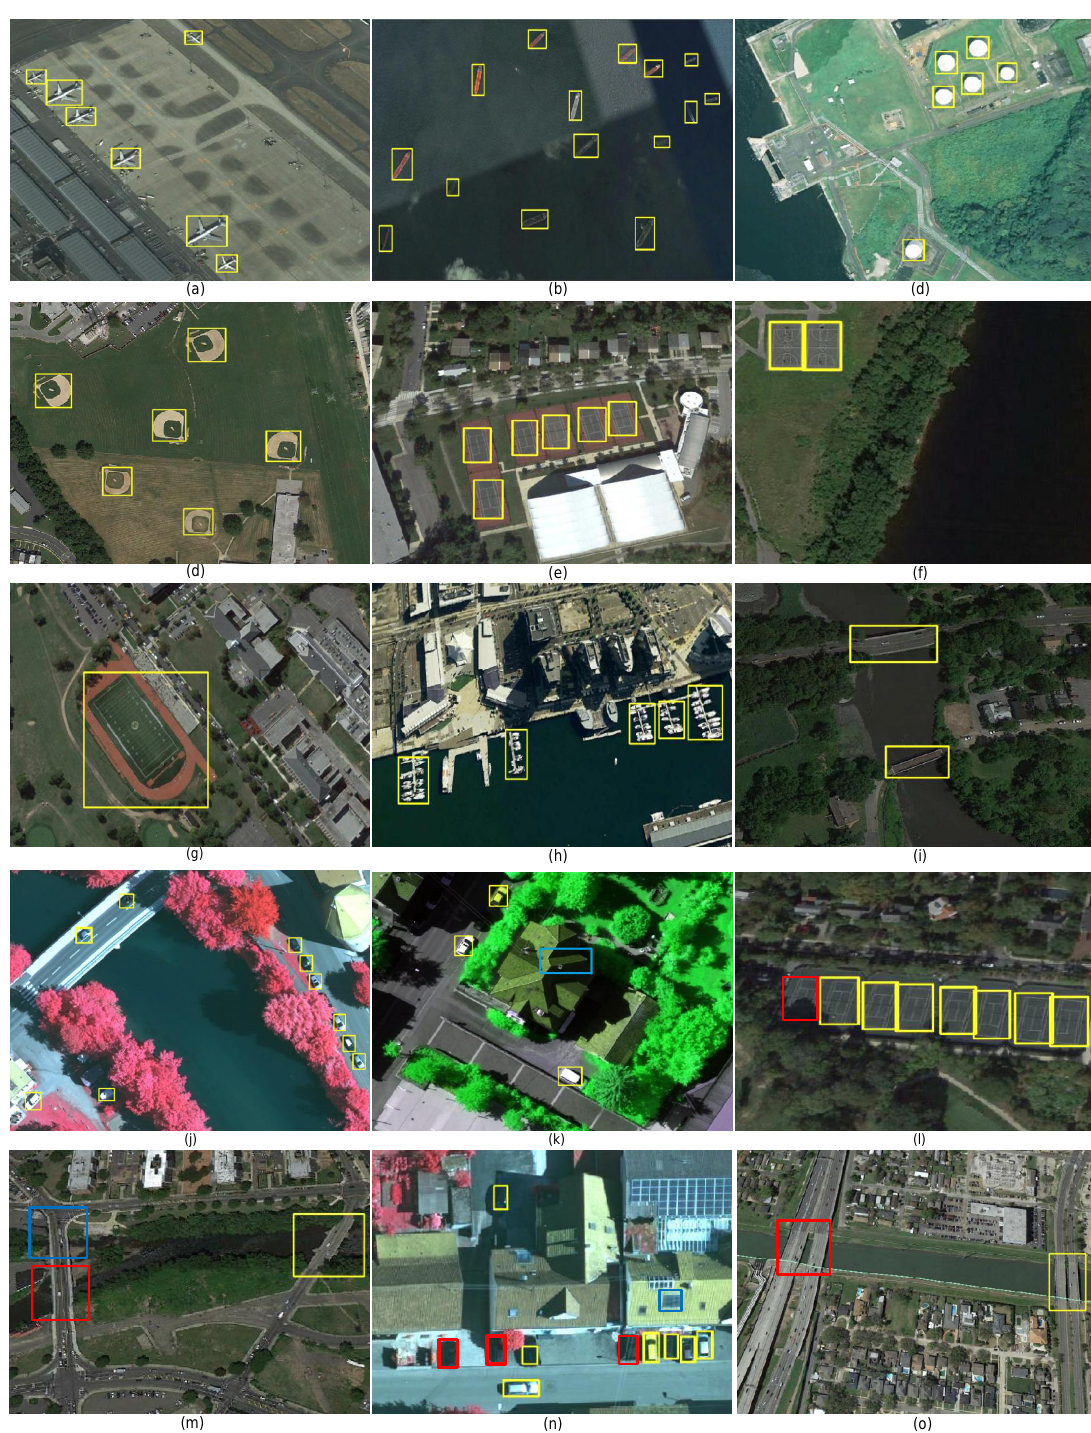
Figure 8. Some object detection results from NWPU VHR-10 dataset. Yellow, red, and blue colors represent true positive, false negative, and false positive cases, respectively. ( a ) airplane, ( b ) ship, ( c ) storage tank, ( d ) baseball diamond, ( e ) tennis court, ( f ) basketball court, ( g ) ground track field, ( h ) harbor, ( i ) bridge, ( j ) vehicle, ( k – o ) show some false positive and false negative